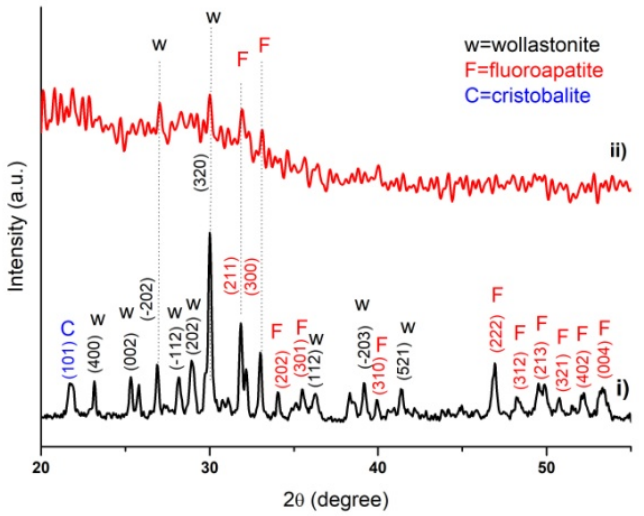
Figure 2. XRD spectra of the Mn-BG target (i) (black line) and of the Mn-BG film deposited on silicon substrate (ii) (red line).